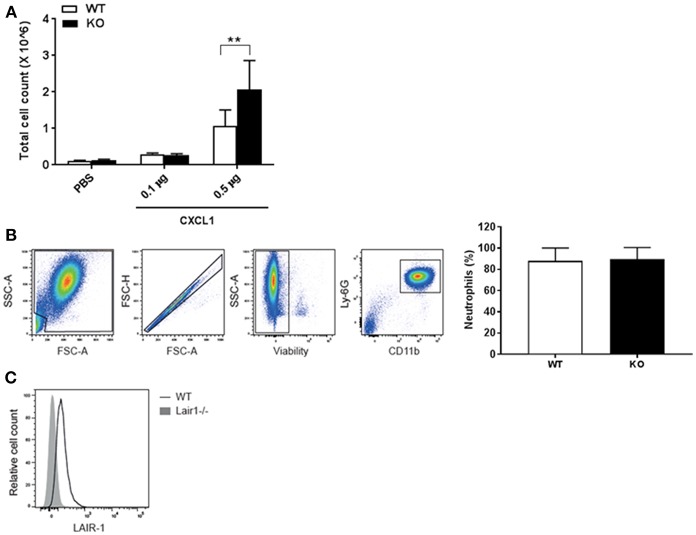
LAIR-1 directly controls neutrophil migration. (A–C) Mice were intranasally instilled with CXCL1 or vehicle (PBS). After 4 h mice were sacrificed and BAL was performed. (A) Total cell counts in BAL fluid were determined and represented as mean ± SD (n = 4–8 mice per group per genotype; 2 independent experiments). Differences between WT and KO in cell influx at CXCL1 (0.5 μg) were consistent in both experiments. **p < 0.01; 2-way ANOVA with Tukey's multiple comparison test. (B,C) Cells in BAL fluid were analyzed by flow cytometry. (B) Neutrophils were identified by concurrent Ly-6G and CD11b expression; graph represents neutrophils as percent of total live leukocytes in BAL fluid after 0.5 μg CXCL1 administration in WT and KO mice, mean ± SD and, (C) a representative histogram of LAIR-1 expression on BAL fluid neutrophils. WT, wild-type and KO, Lair1−/− on C57BL/6 background.